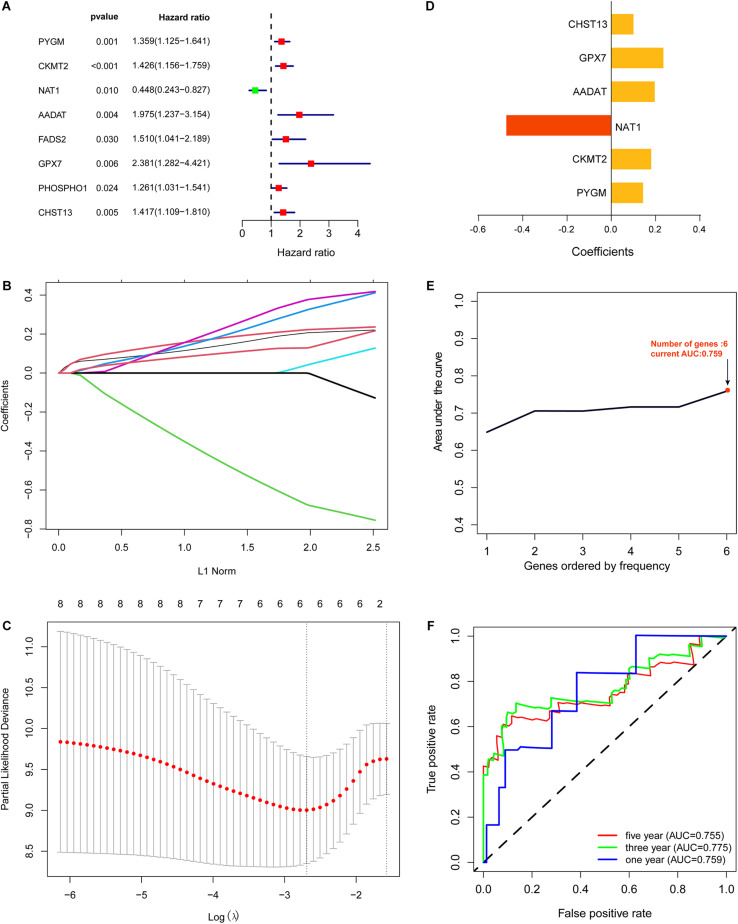
Construction of metabolic gene signature. (A) Univariate Cox regression analysis showed that eight out of the 64 differentially expressed metabolic genes significantly correlated with the overall survival of OS patients (P < 0.05). (B,C) Lasso Cox regression analysis showing that six out of the eight metabolic genes were good candidates for constructing the prognostic signature. (D) Coefficients of six out of the eight metabolic genes. (E) Six metabolic genes signature constructed by iterative Lasso cox regression analysis. (F) ROC curve to evaluate 1, 3, and 5-year prediction efficiency of the six metabolic genes signature.